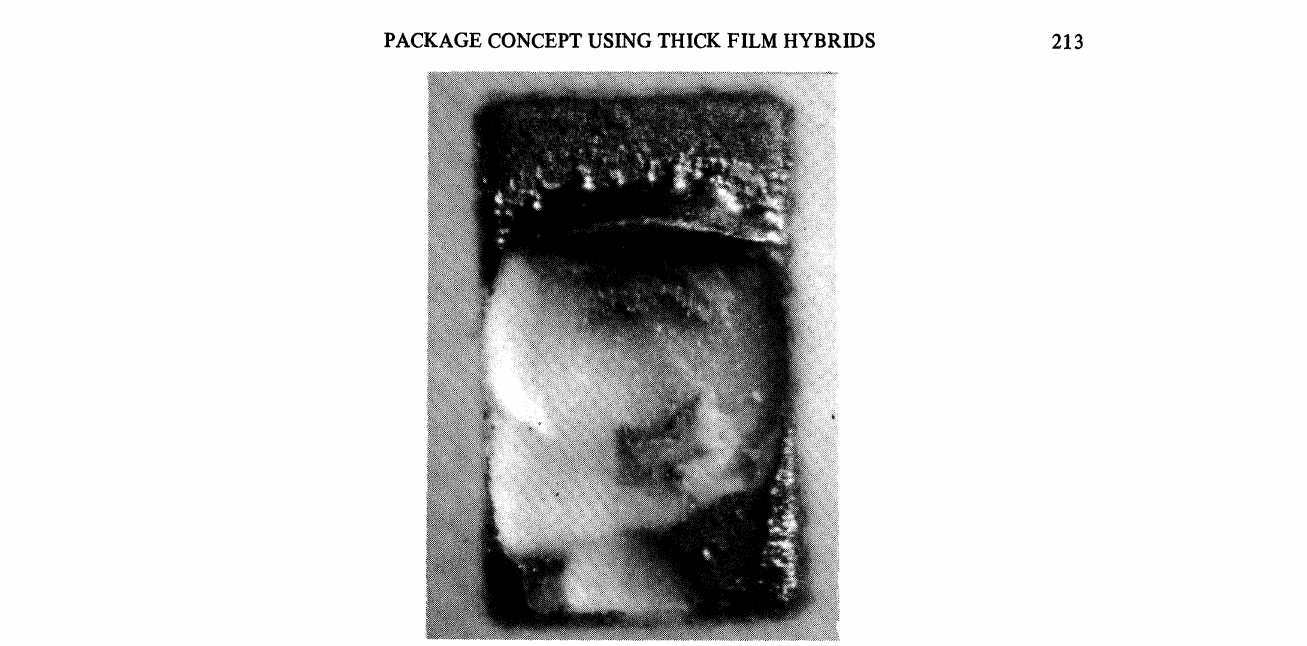
FIGURE 5 Cavity pulled out of the multilayer structure with a force of 23